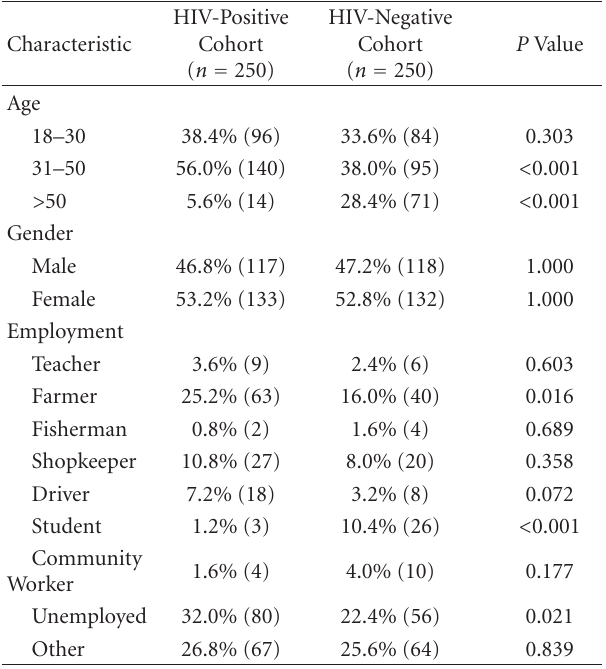
Table 1: Demographic Characteristics of the Study Population.